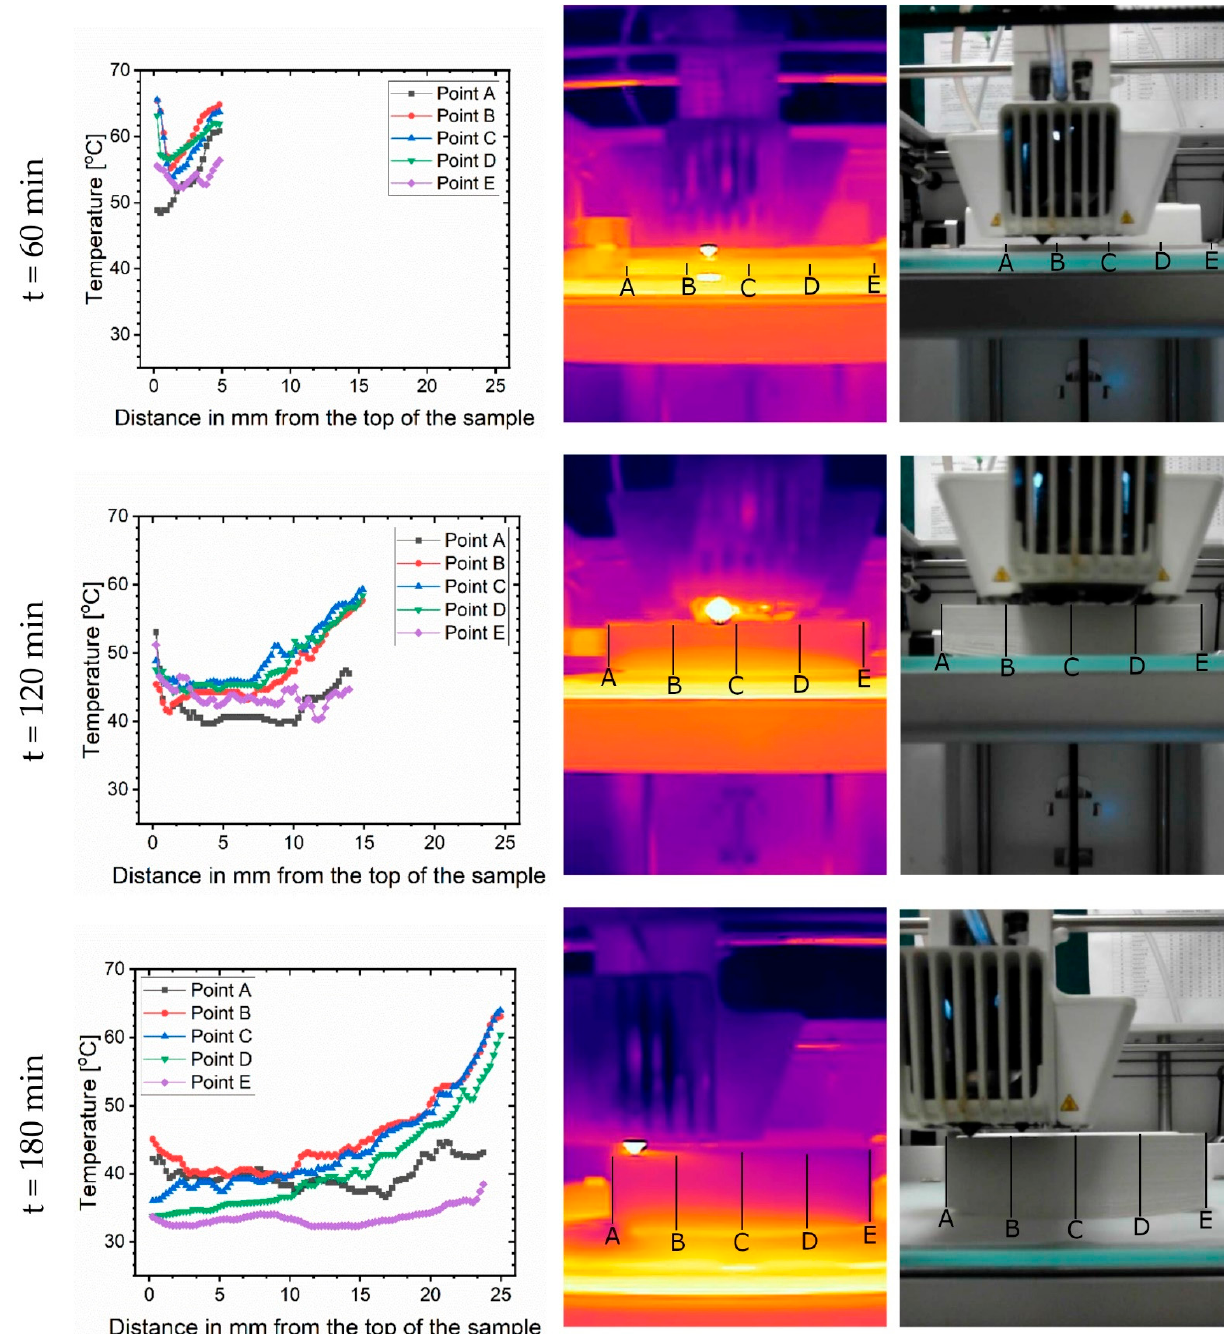
Figure 16. From left to right: temperature profiles, infrared, and visible pictures of the sample at three time points: 60 min, 120 min and 180 min, respectively.